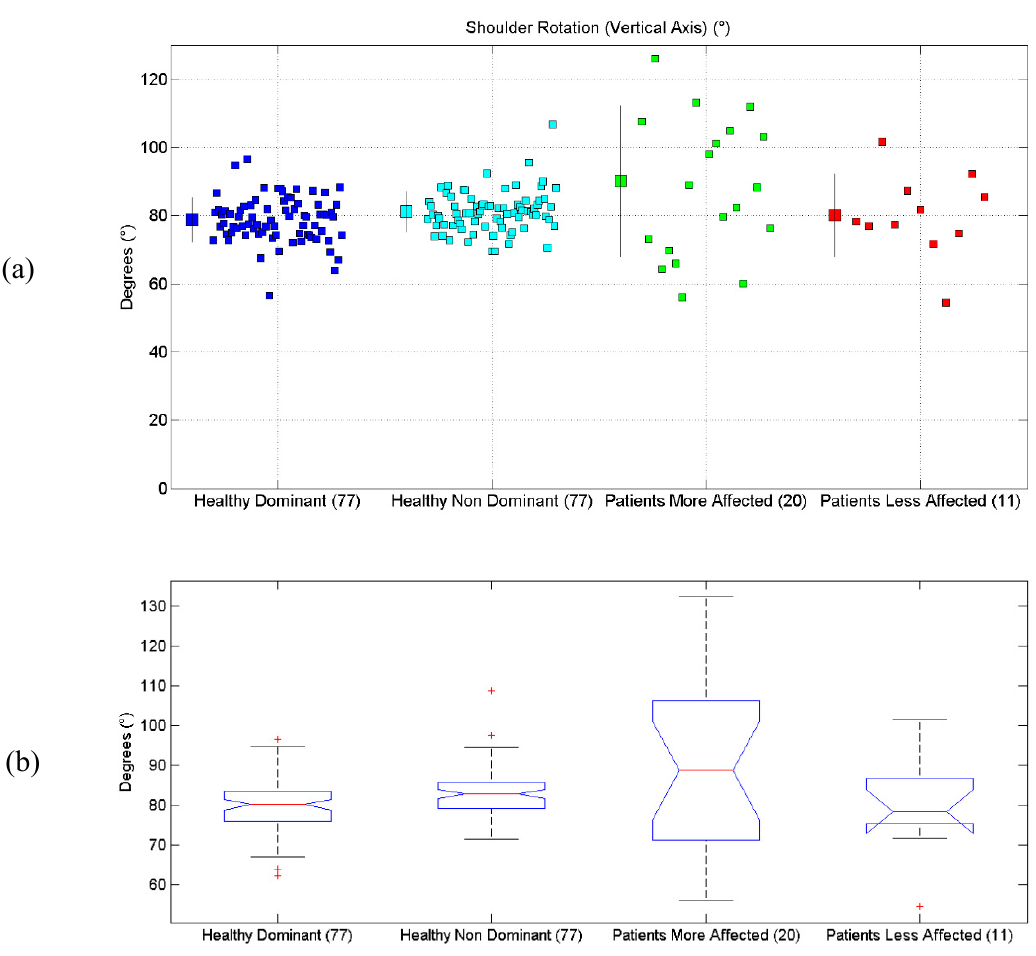
Figure 5. ( a ) Scatterplot for Shoulder Rotation Angle for the four considered groups. Mean (SD) of each population (considered limb) are reported. ( b ) Distributions of Shoulder Rotation Angle, are shown for the four experimental conditions. The central line indicates the median, while the lower and upper extremities of the boxes represent the 25th and 75th percentiles, respectively. The whiskers comprise all the data points distribution, except the outliers, which are plotted separately using the ‘+’ mark.